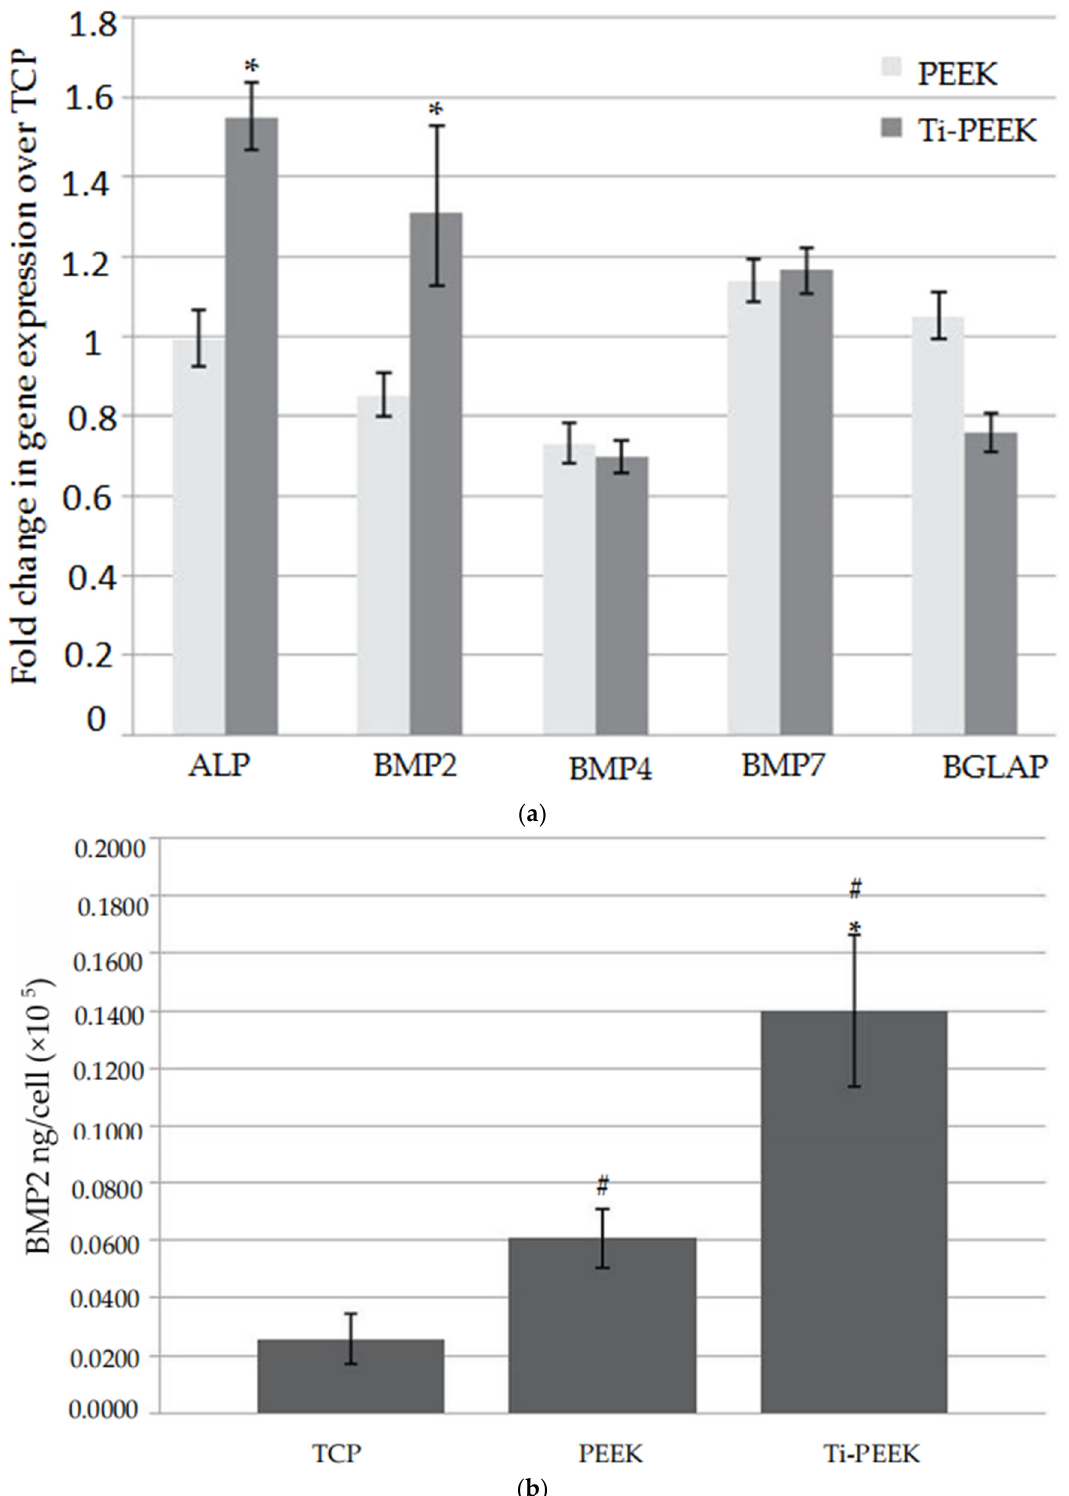
Figure 4. Gene expression of bone markers; protein levels of Ti-PEEK and PEEK groups. ( a ) Fold changes in gene expression of bone markers (normalized to GAPDH) over TCP control (calibrator = 1) in osteoblast-like cells cultured on Ti-PEEK and PEEK surfaces; * 95% CIs of mean fold change values of Ti-PEEK and PEEK do not overlap; ( b ) BMP-2 protein levels secreted by osteoblast-like cells cultured on Ti-PEEK, PEEK and TCP surfaces; * p < 0.05 vs. PEEK; # p < 0.05 vs. TCP. (Reproduced from [72], with permission from © 2018 Dovepress). GAPDH: glyceraldehyde 3-phosphate